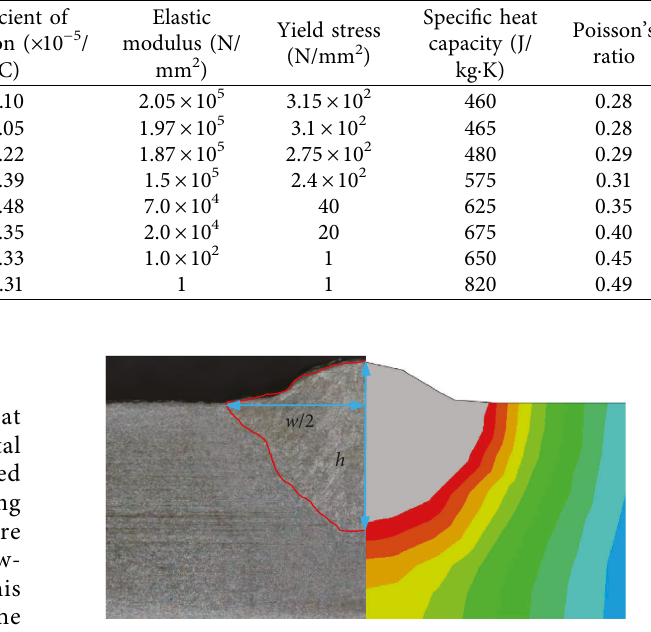
Figure 9: Molten pool contour comparison between experimental tests and FEA. Table 6: Geometry dimensions of the molten